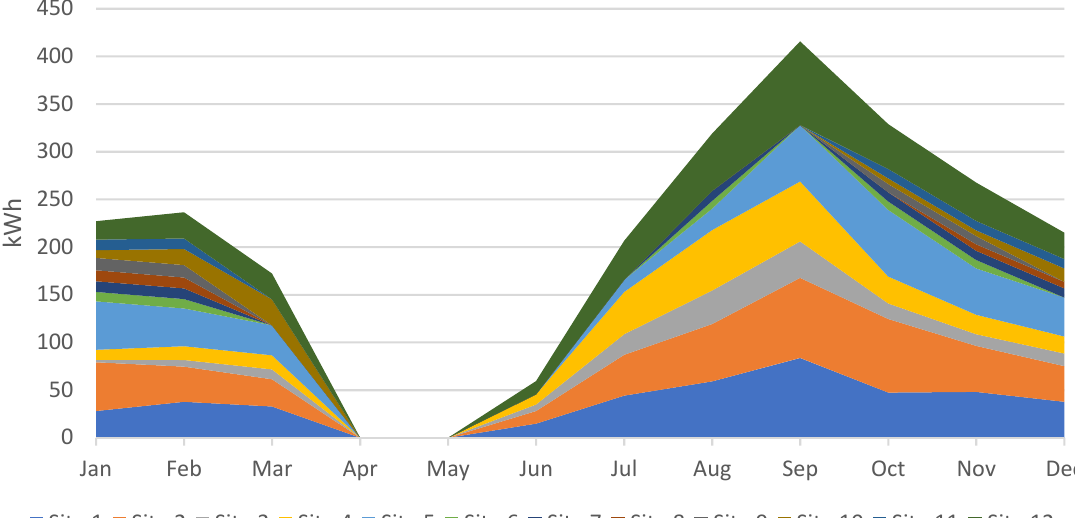
Figure 9. Monthly energy consumption at each site throughout the year.